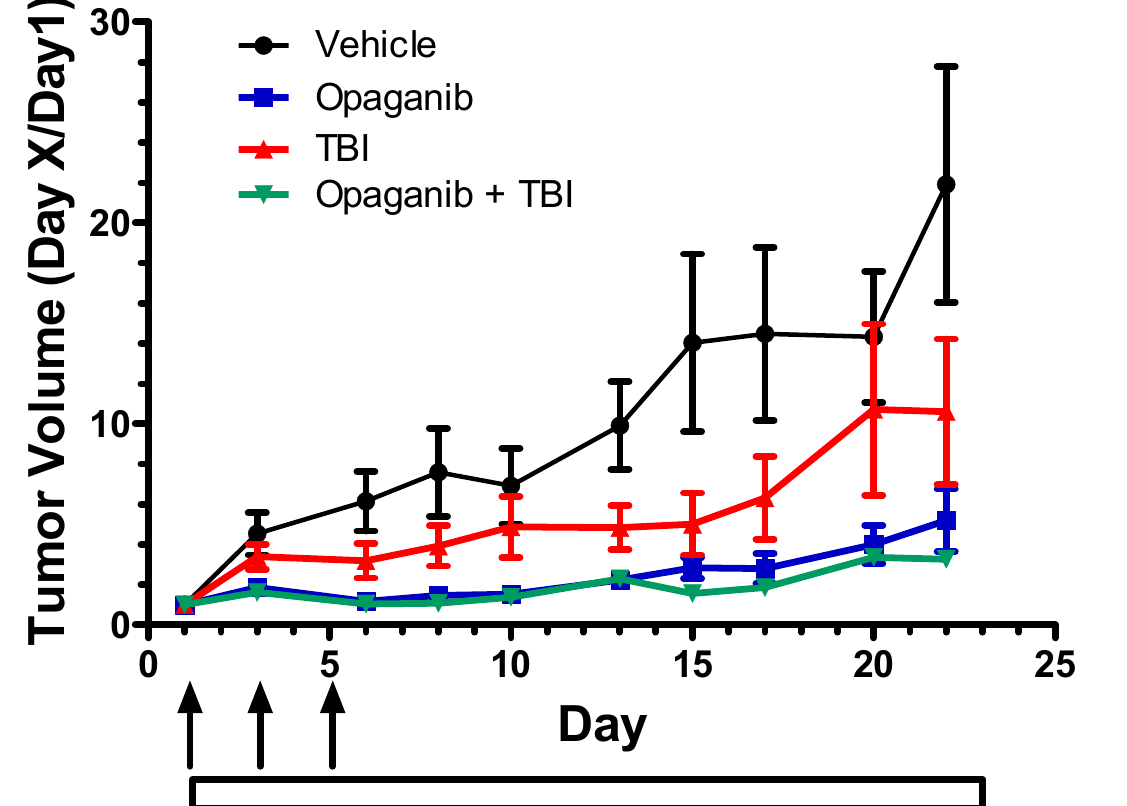
Figure 9. Antitumor efficacy of opaganib and radiation toward pancreatic tumors. C57/BL6 mice were subcutaneously injected with 10 6 PAN02 cells. When tumors reached 100–150 mm 3 , animals were randomly assigned into one of four groups ( n = 10/group): Vehicle ( ● ); 25 mg/kg opaganib daily (5 × /week) ( (cid:4) ); fractionated TBI (1 Gy, 3 times ↑ ) ( (cid:78) ); or combination of opaganib and TBI ( (cid:72) ). Mice in the combination group were treated with opaganib 2 h prior to radiation.